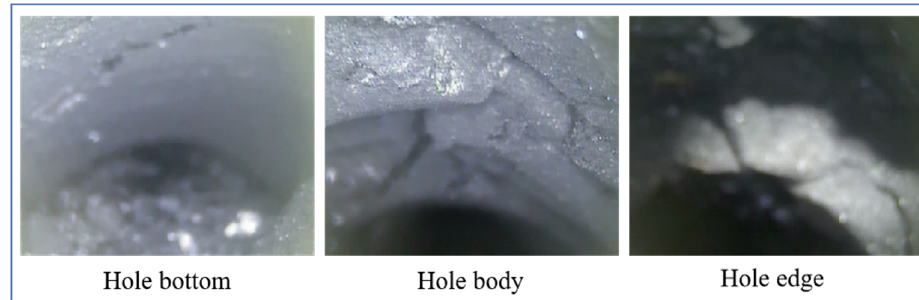
Figure 21. Characteristics of the borehole peep hole.